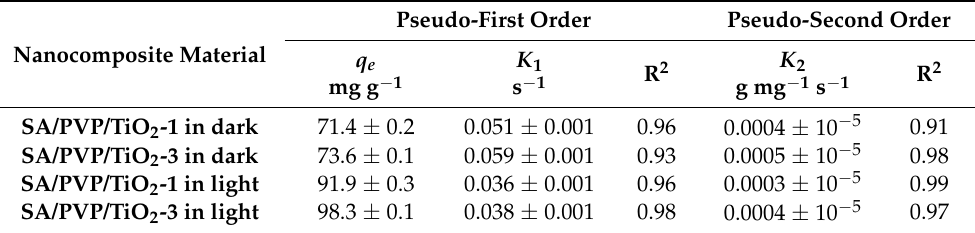
Table 2. Kinetic parameters determined for the pseudo-first order and pseudo-second order models.